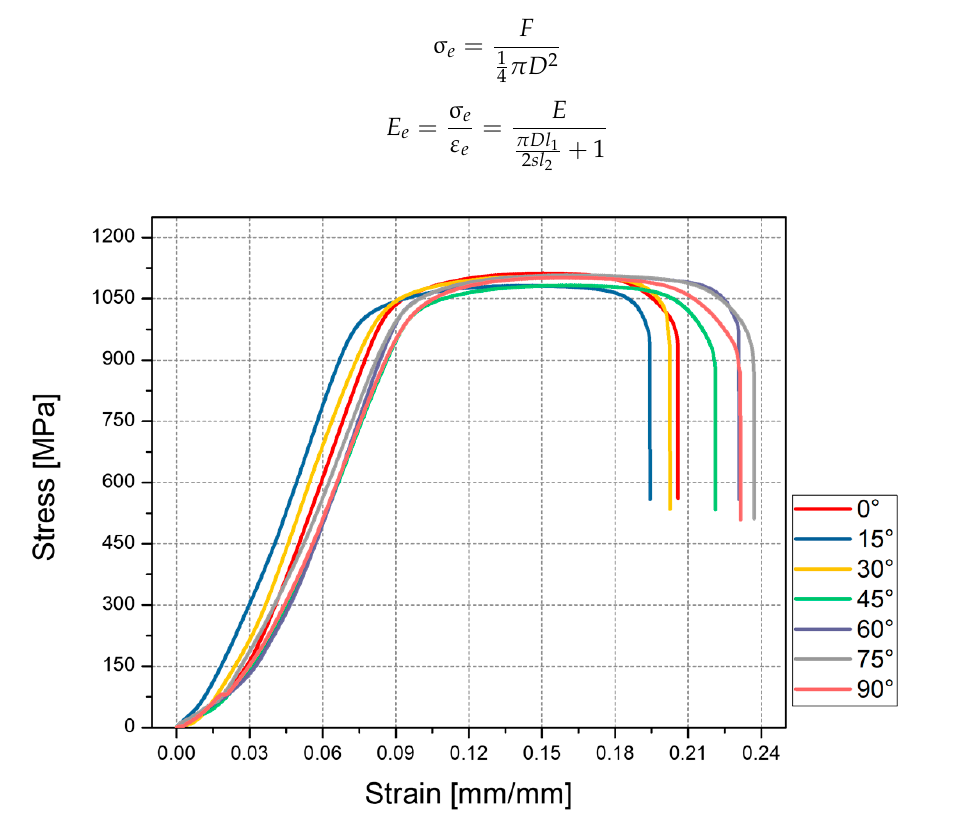
Figure 9. Stress–strain response of the RB sample with diameter of 1.75 mm.